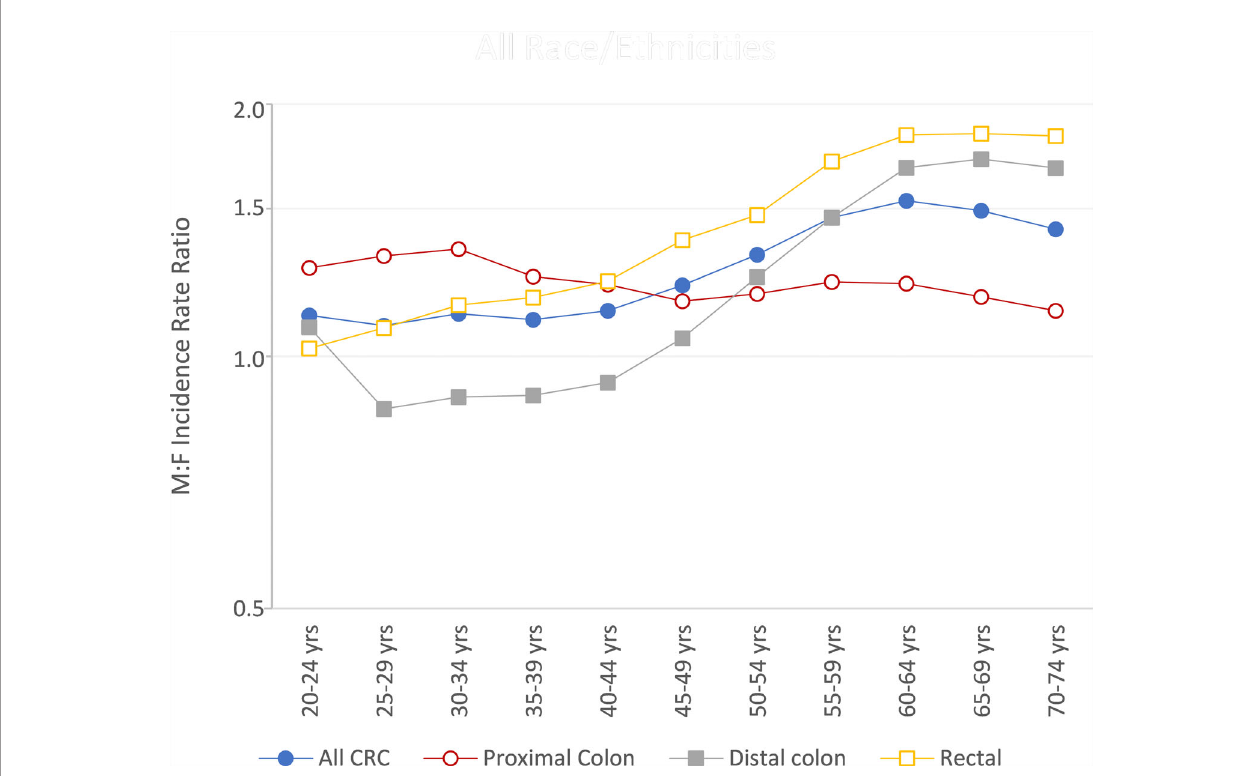
FIGURE 2 | Colorectal cancer male-to-female (M/F) incidence rate ratios by age and subsite, US Cancer Statistics